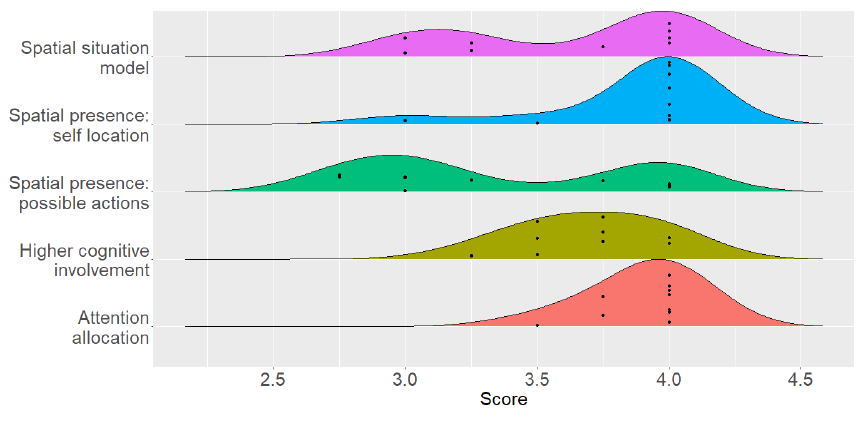
Figure 8. Distributions of factor